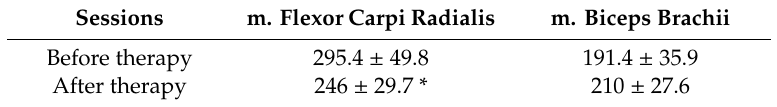
Table 1. Mean ± SD muscle stiffness (N/m) before and after transcranial direct current (tDCS) therapy.